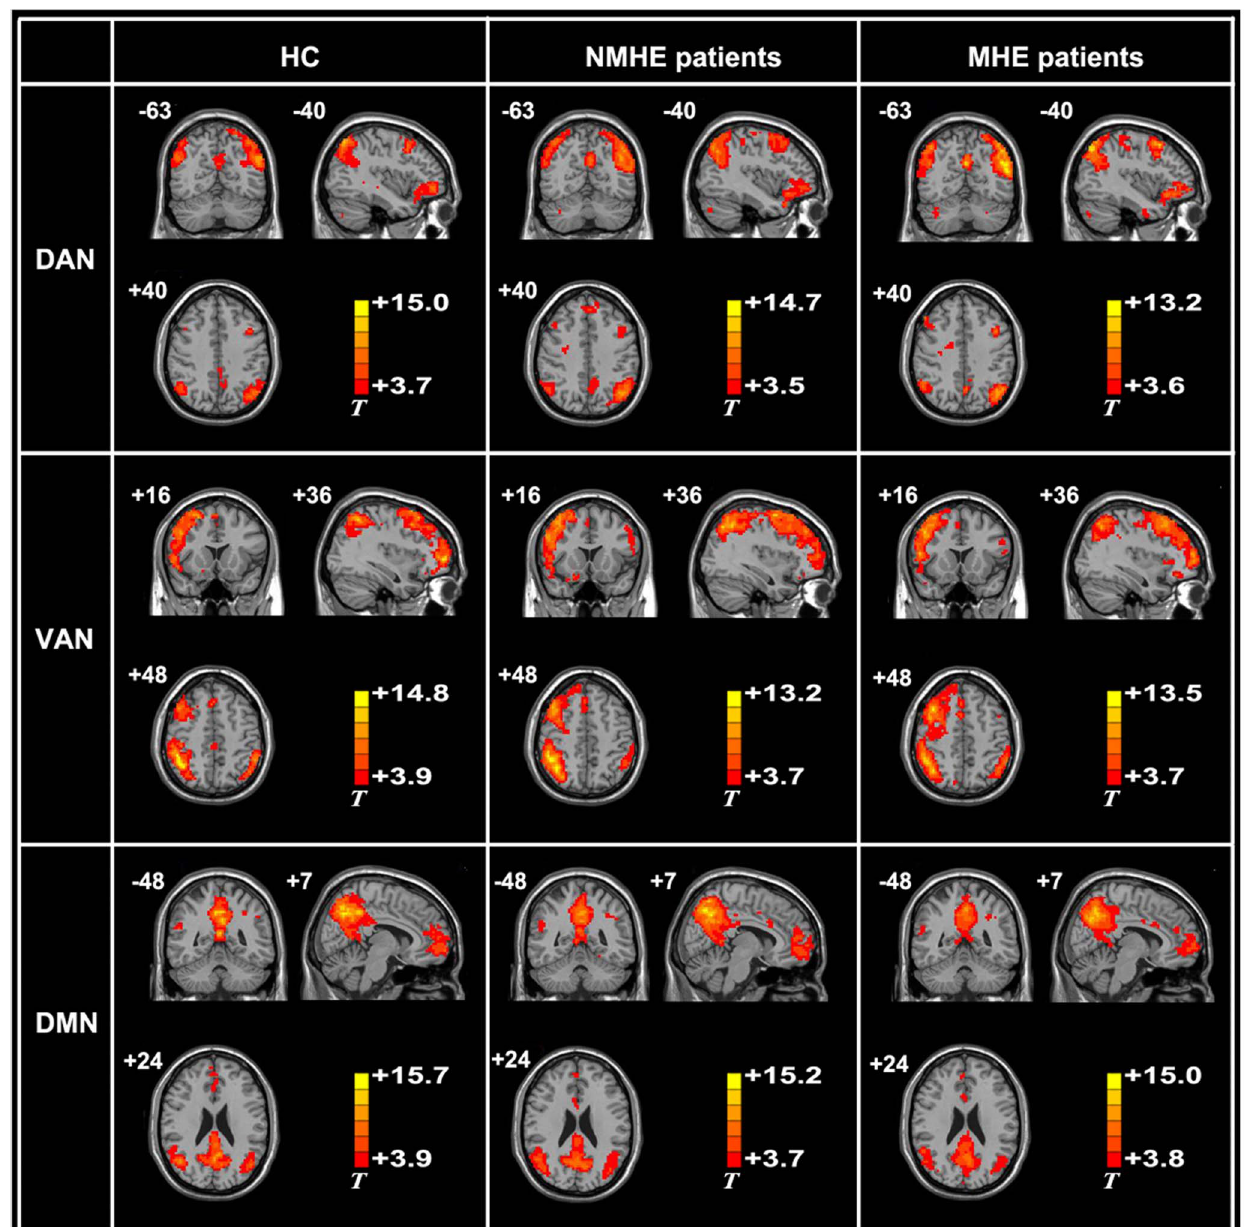
Figure 2. The spatial pattern of the dorsal attention network (DAN), ventral attention network (VAN), and default mode network (DMN) in healthy controls (HC), the cirrhotic patients without minimal hepatic encephalopathy (NMHE patients), and cirrhotic patients with minimal hepatic encephalopathy (MHE patients). Left side of image denotes right side of brain. doi:10.1371/journal.pone.0089684.g002 73.2%, 63.4%, 73.2% classification accuracy, between MHE group and NMHE group. 3.549; while the discriminate score can be calculated by the below function between MHE and NMHE groups: Function =0.708 6 F1 + With FC strength of ROIs from three networks as indicators, the optimal classification results could be obtained. LDA analysis showed 94.6% classification accuracy, with 100% sensitivity and 88.2% specificity, between MHE group and HC group; and yielded 85.4% classification accuracy, with 90.0% sensitivity and 81.0% specificity, between MHE group and NMHE group (Table 5). With the FC strength of ROI1 , ROI5 (see Figure 3) as five features, the discriminate score can be calculated by the below function between MHE and HC groups: Func-